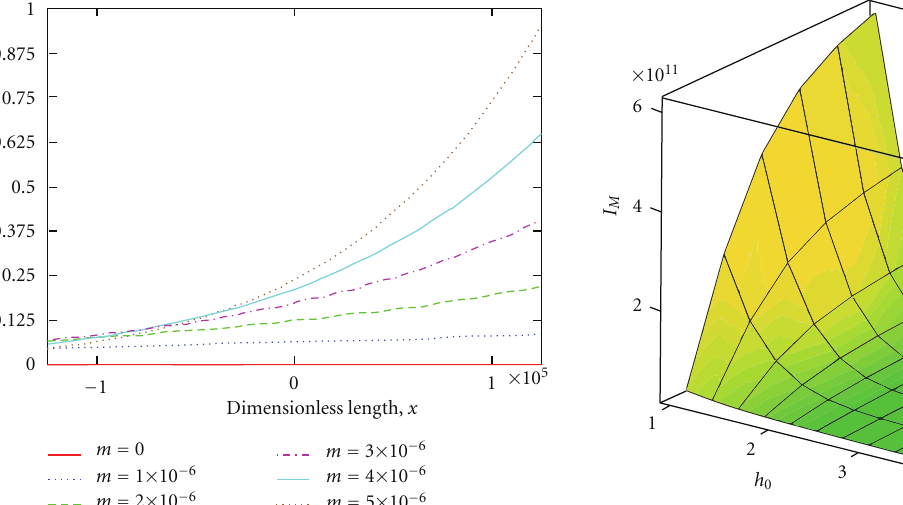
Figure 12: Dimensionless tangential force, I x , versus x for h 0 = 1, β s = 500 , and a = 250000.